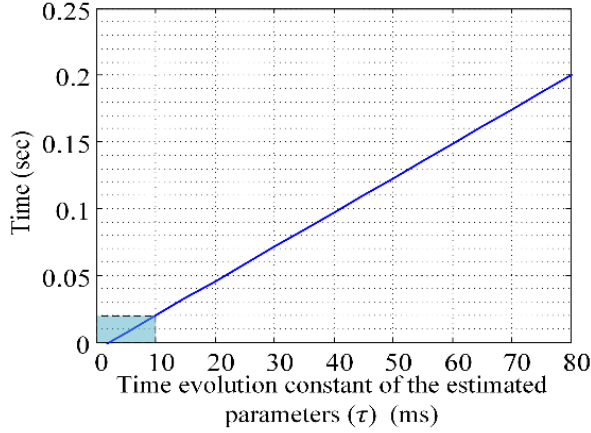
Figure 12. Index of the estimated parameters 𝒏 𝒔/𝒄 .